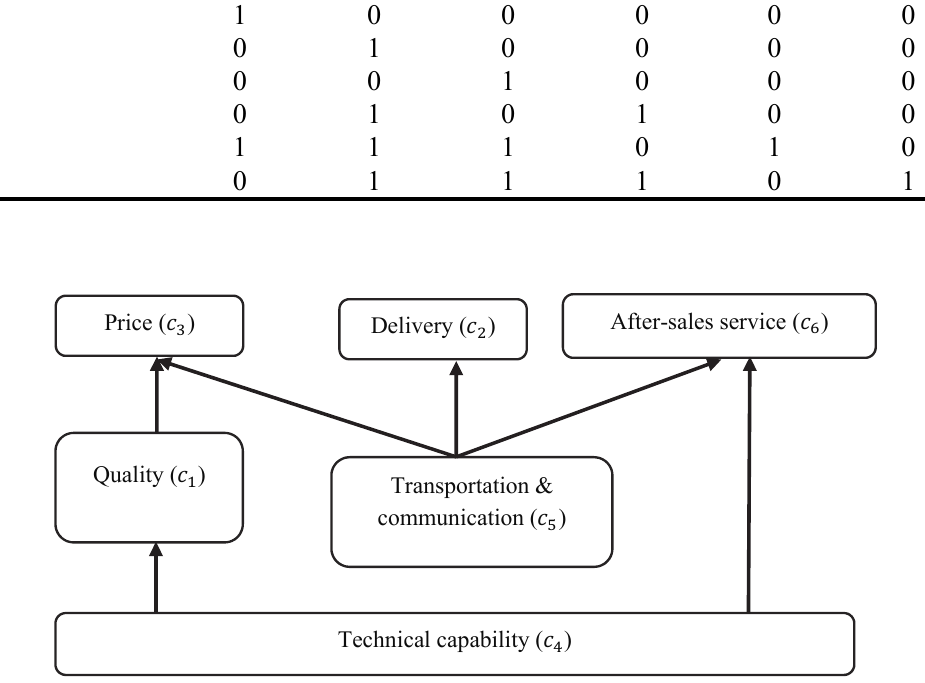
Fig. 2. Final digraph showing the relationships between the